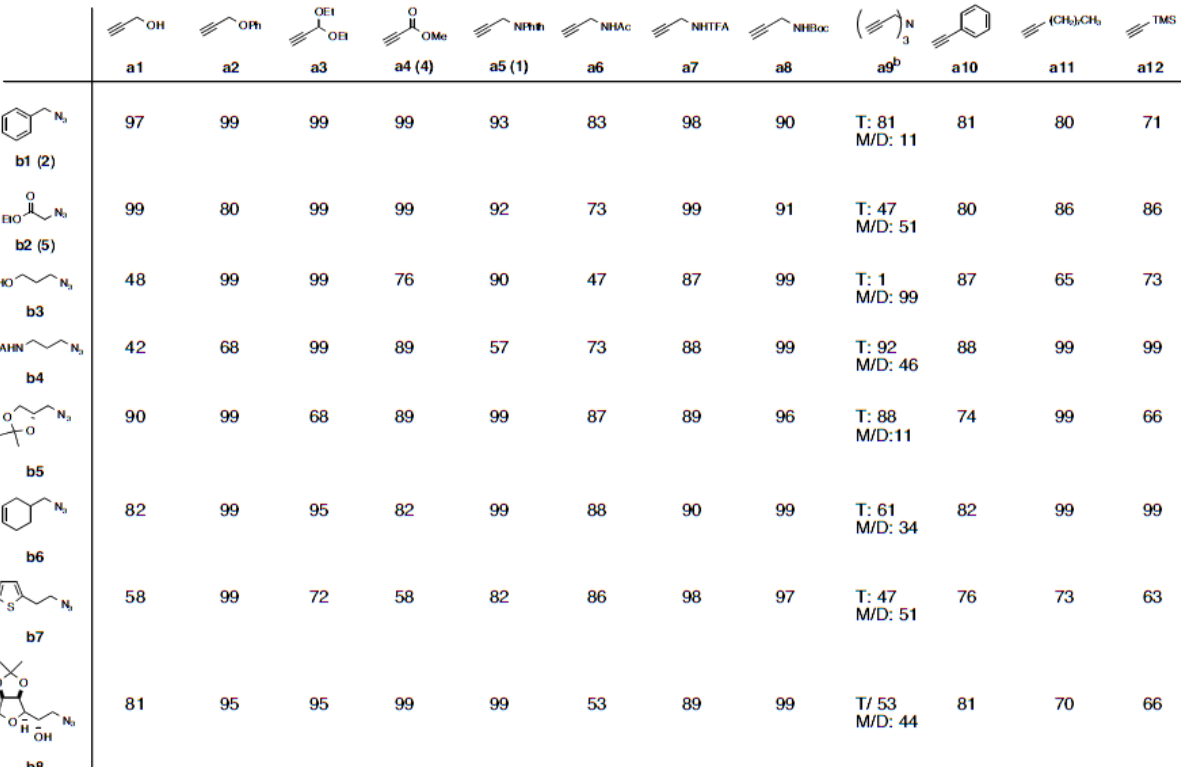
Table 2. Parallel synthesis of 96 triazoles using Amberlyst A-21-CuI on a ChemSpeed ASW-2000 with 8 azides and 12 Alkynes.